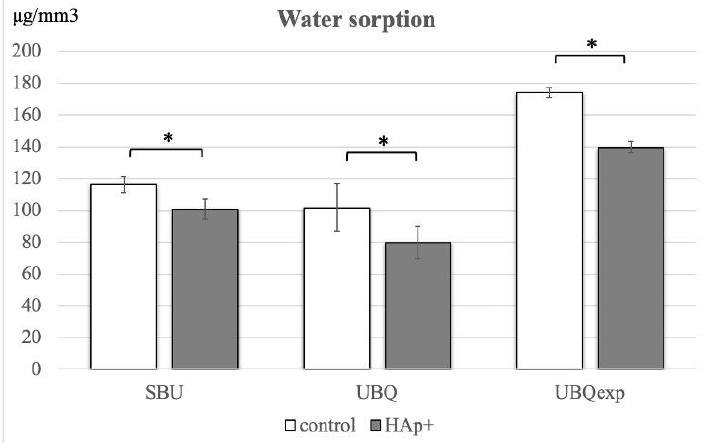
Figure 2. Water sorption values of the commercial 1-SEAs Scotch Bond Universal (SBU), Universal Bond Quick (UBQ), and Experimental 1-SEA (UBQ exp ). Asterisks show statistically significant differences ( p < 0.05) ( n = 7).